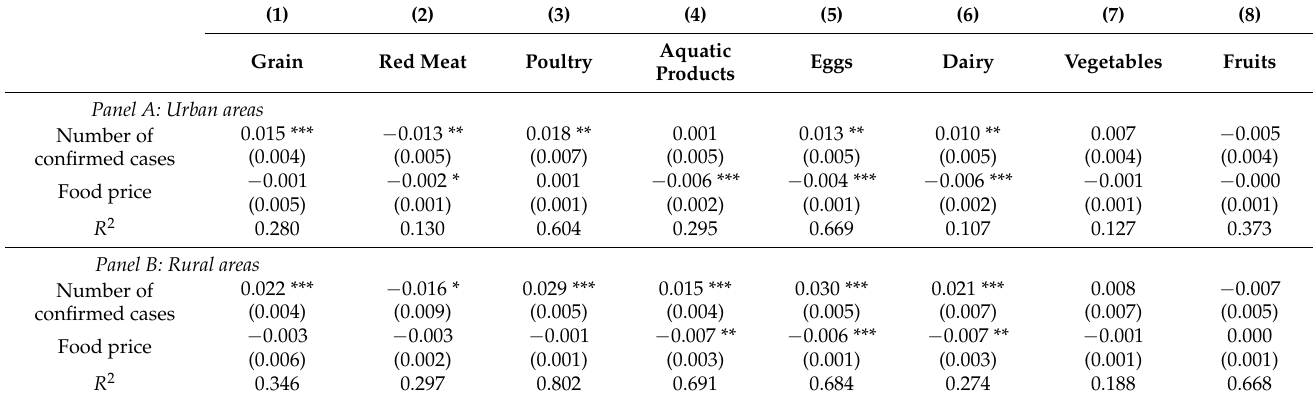
Table A1. Robustness checks: food price as an additional control